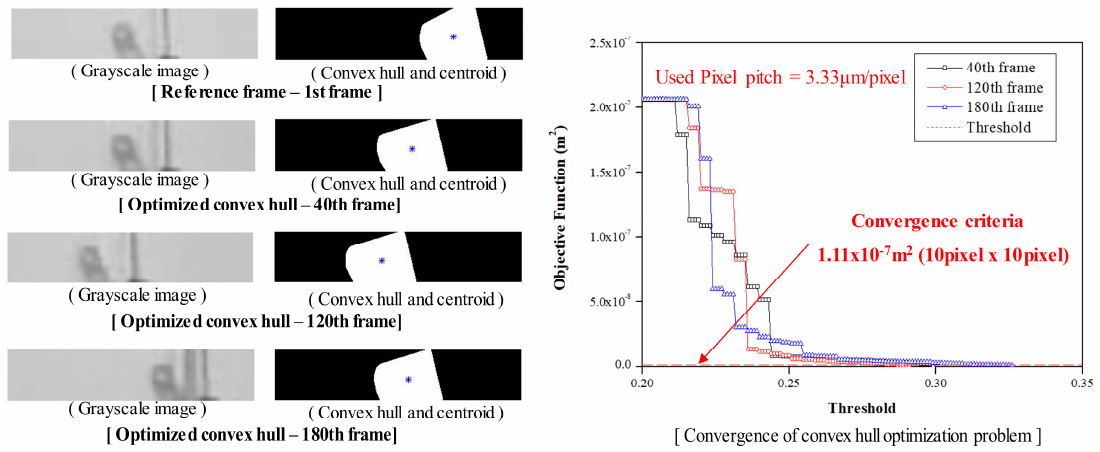
Figure 4. Gray scale image and its convex hull to extract feature point; Convergence of image convex hull optimization method for specific convergence criteria